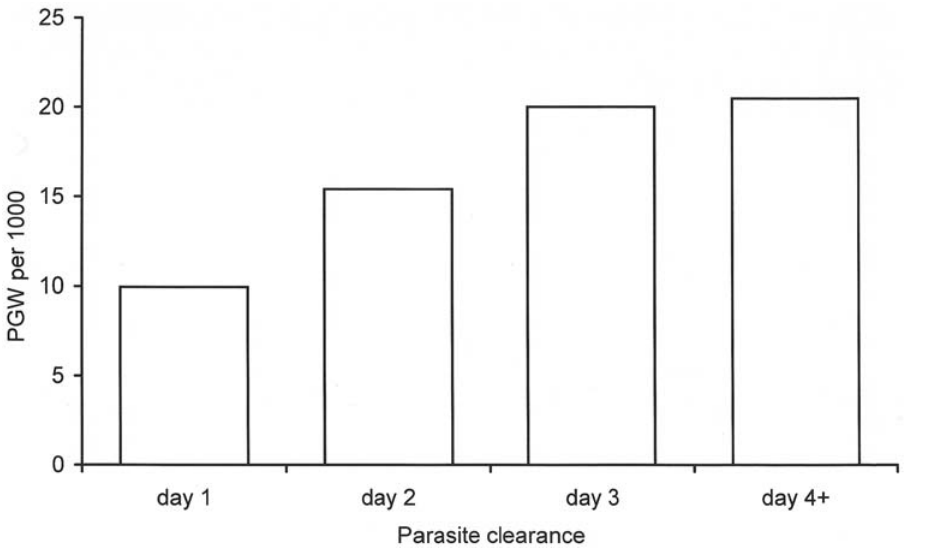
Figure 2. Relationship between parasite clearance time and gametocyte carriage. Gametocyte carriage rate is expressed per 1,000 person- gametocyte-week (PGW).